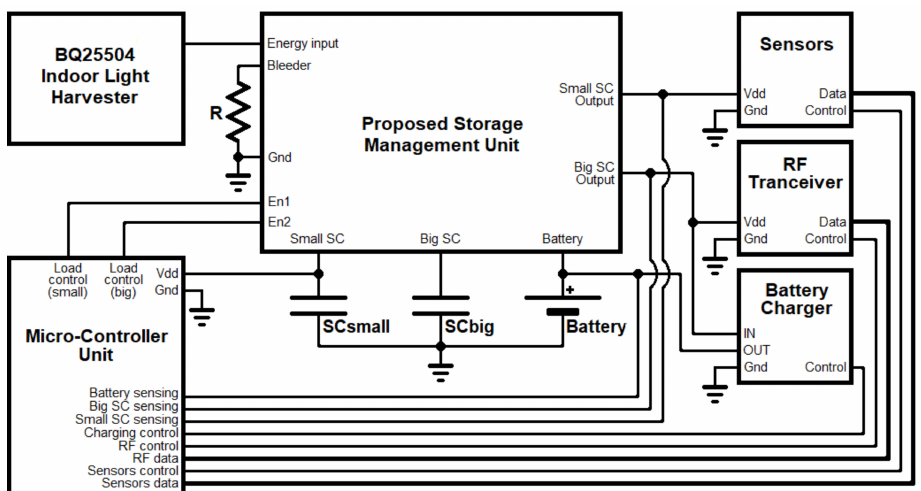
Figure 16. Future work WSN